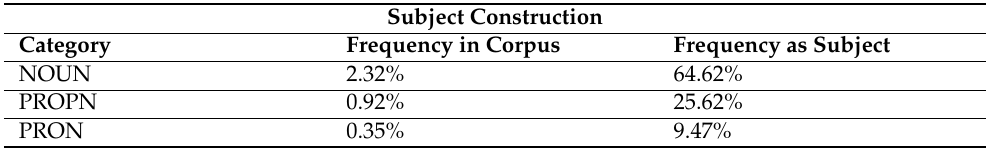
Table 5. Frequency within subject